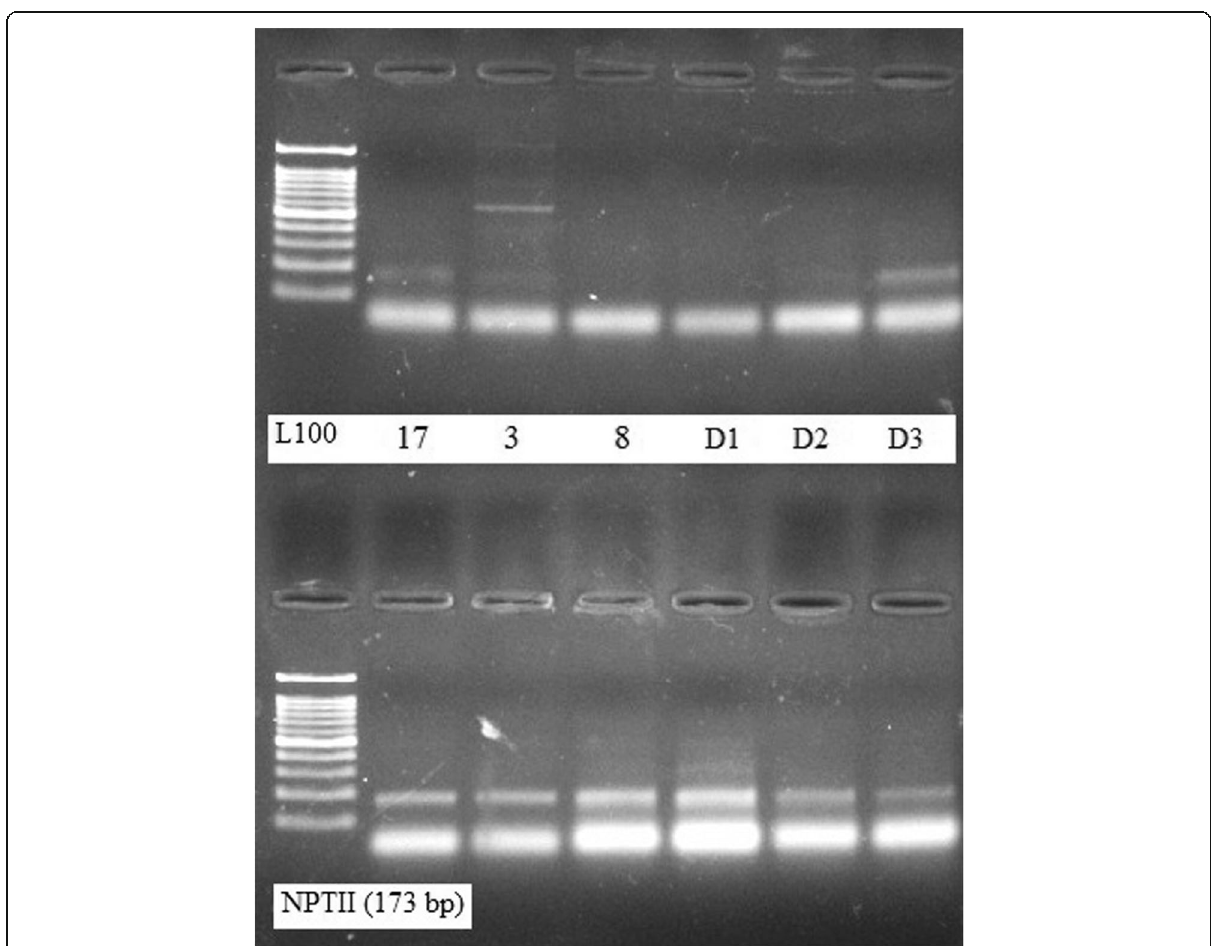
Fig. 5 PCR amplification with nptII for detection of GM crops. Quality of the amplification of nptII (173 bp target) in the representative of DNA samples which were extracted by the conventional method (upper lane) and the standardized protocol (lower